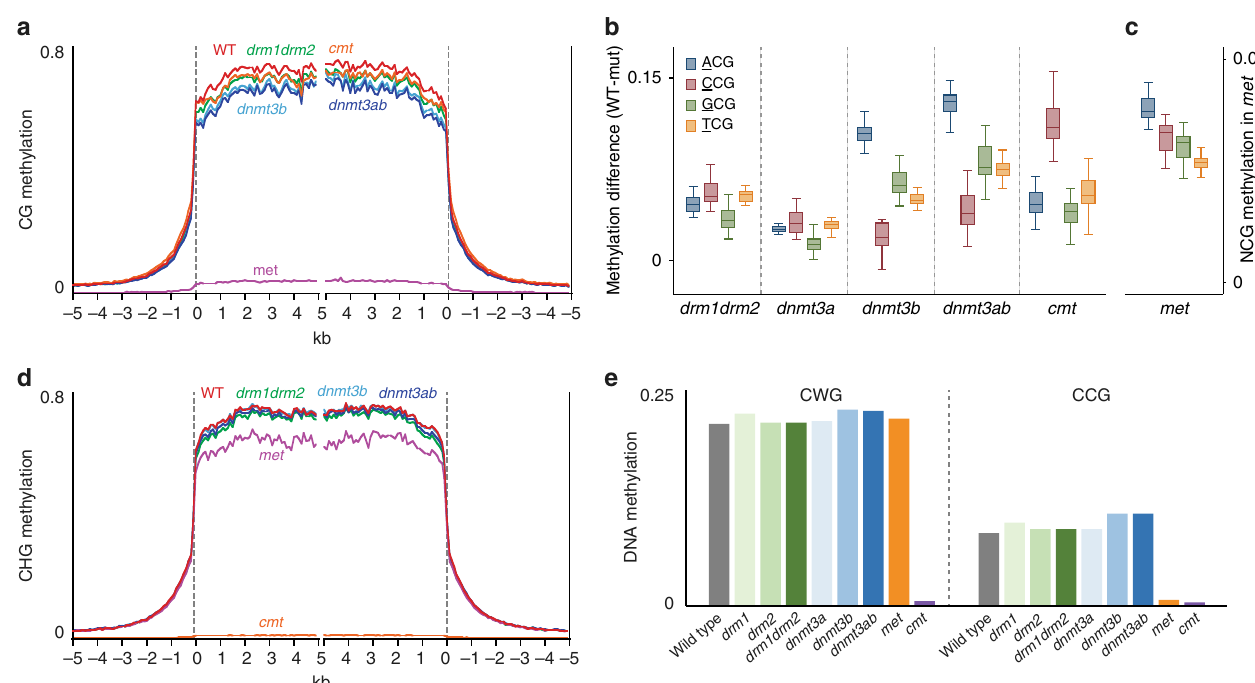
Fig. 2 Genomic CG methylation regulation by PpCMT and PpDNMT3b. a Patterns of TE CG methylation in WT and indicated mutants. P. patens TEs were aligned at the 5 ′ end and average methylation for all cytosines within each 100 bp interval is plotted. The dashed lines represent the points of alignment. b Box plot of NCG methylation difference in TEs between WT and indicated mutants (N = any nucleotide). c Box plot of the residual NCG methylation in TEs in met mutant. Boxplots throughout the manuscript show the interquartile range (IQR) (box), center lines represent the median, and the whiskers corresponding to 1.5 times the IQR. d Patterns of TE CHG methylation in WT and indicated mutants (similar to B). e Averaged genomic CHG methylation level in WT and DNMT mutants separated to CWG (i.e., CAG or CTG) and